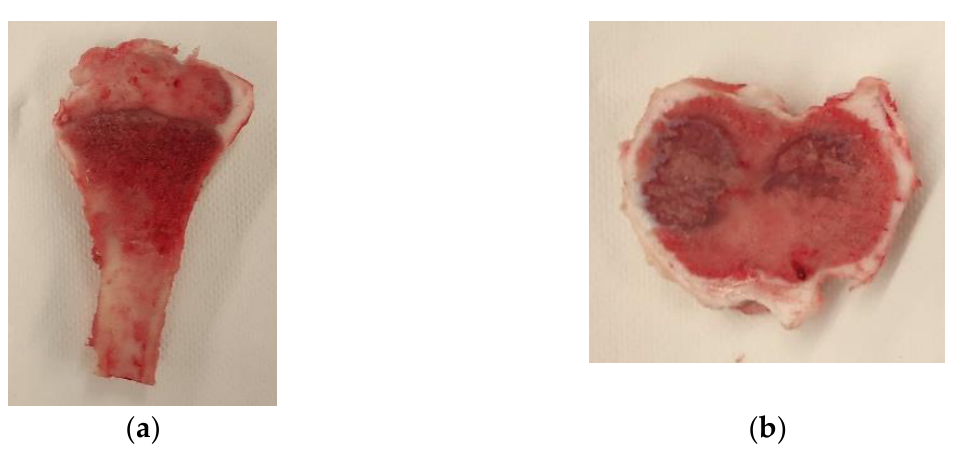
Figure 2. Trabecular bone slices: ( a ) for the transverse load direction; ( b ) for the longitudinal load direction.